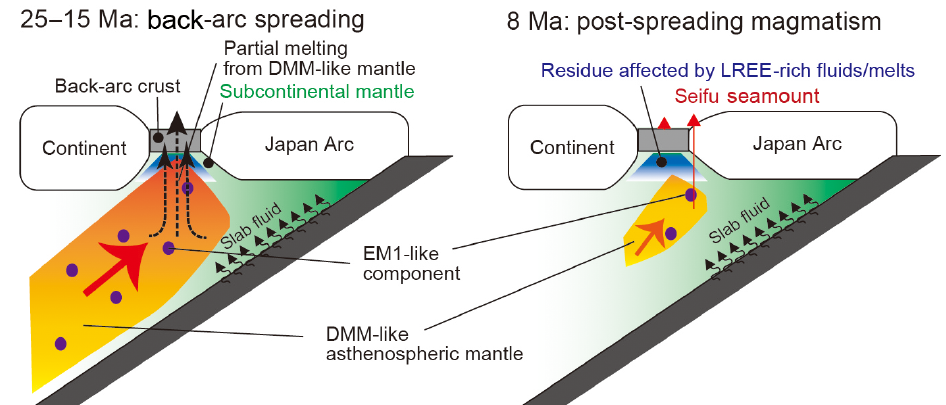
Figure 10. Schematic models showing back-arc spreading magmatism (25–15Ma) and post-spreading magmatism (8Ma) in the Sea of Japan. The SSM basalt was formed by a low-degree partial melting of spinel peridotite having DMM with a minor EM1-like component during post-spreading magmatism. The SSM basalt contains subcontinental mantle and residue after open system melting affected by the infiltration of LREE-enriched fluids and